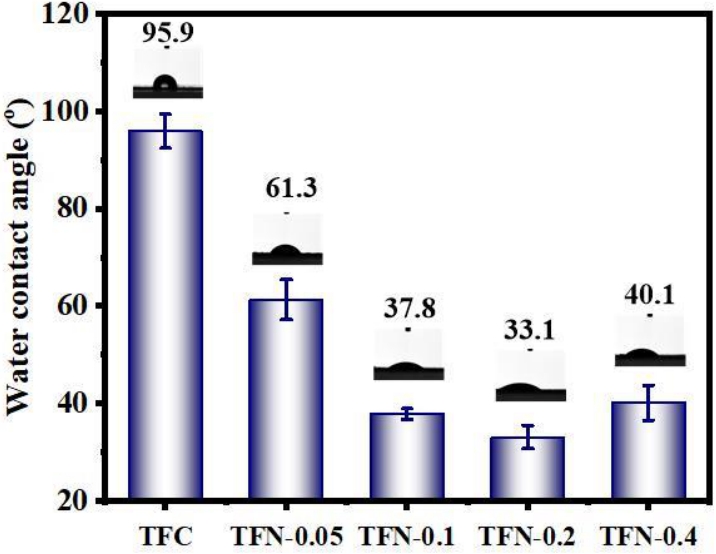
Figure 7. Water contact angle of TFC and TFN membranes.